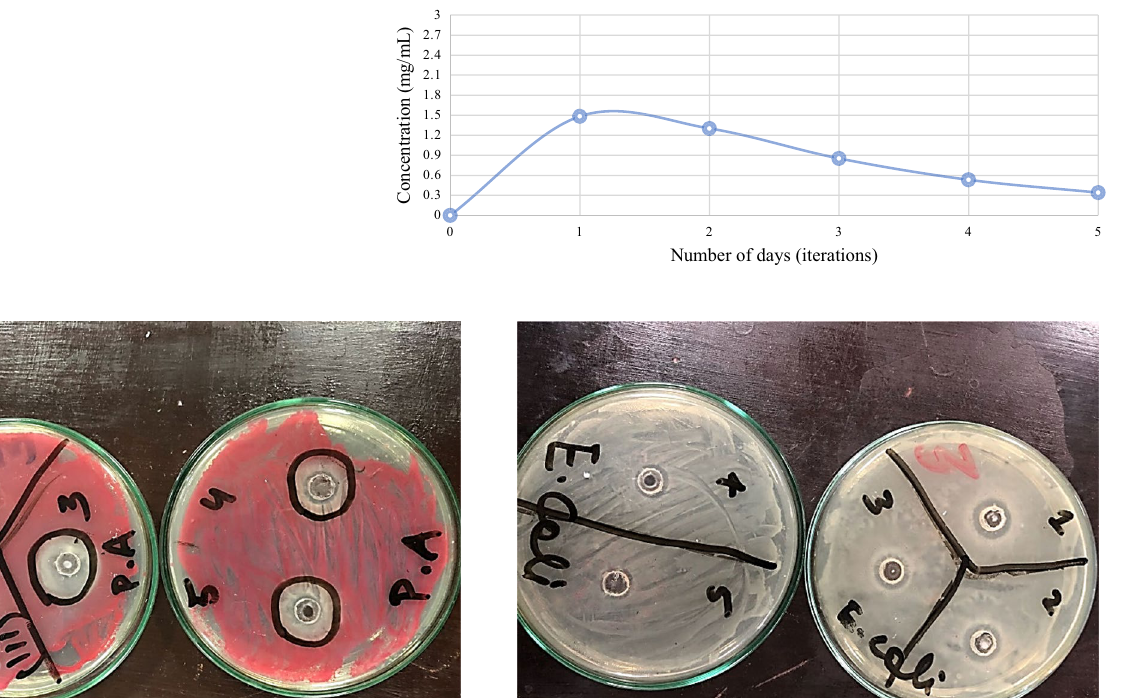
Fig. 11 Cumulative drug release profile